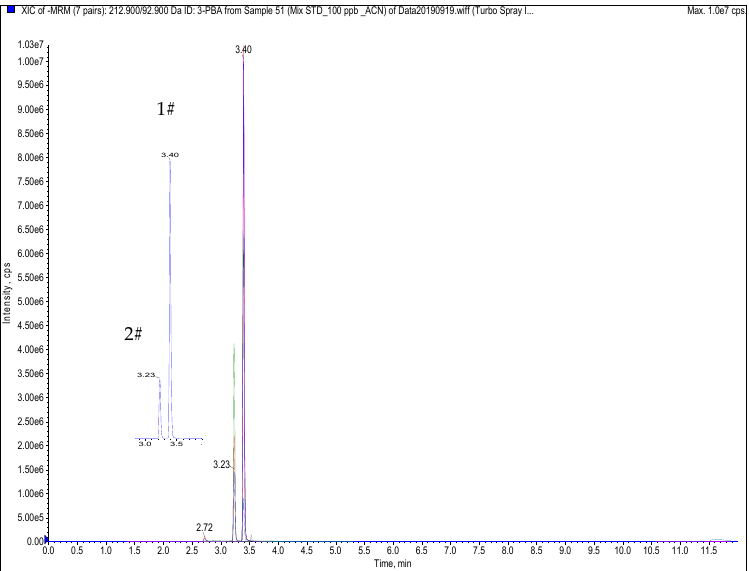
Figure 2. Ultra-high performance liquid chromatography coupled with tandem mass spectrometry (UHPLC-MS/MS) chromatograms of three target compounds and internal standard 2-PBA (peak 1 # means 3-PBA and peak 2# means 2-PBA) obtained from Kinetex C18 (100 × 2.1 mm id, 2.6 µ m particle size) under the mobile phase A water and phase B methanol. Note, gradient elution: 0–1 min